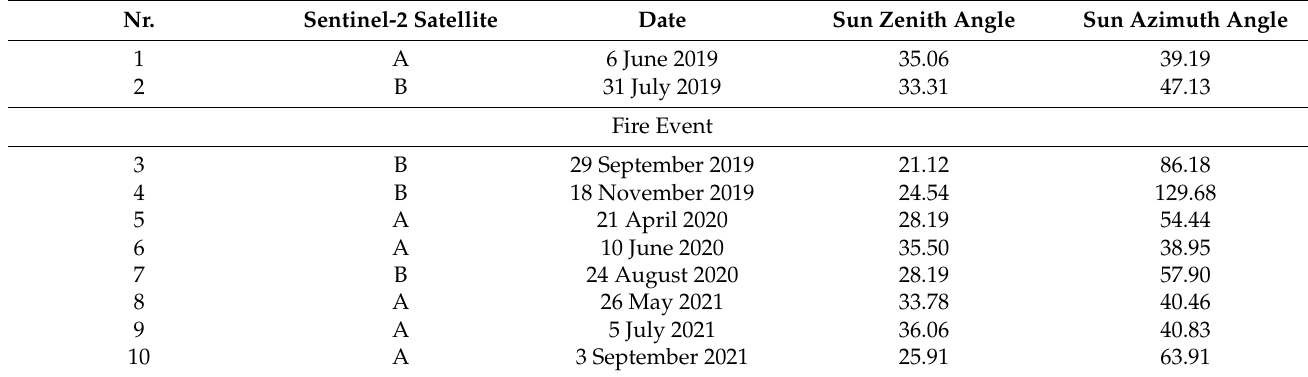
Table 3. Summary of selected Sentinel-2 scenes; Granule: